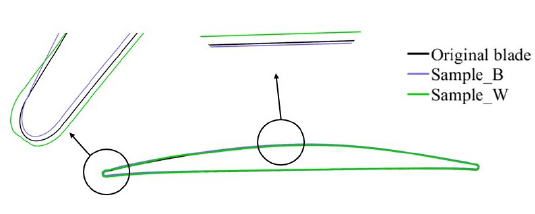
Figure 16. Pressure ratio and efficiency characteristics at different speeds.